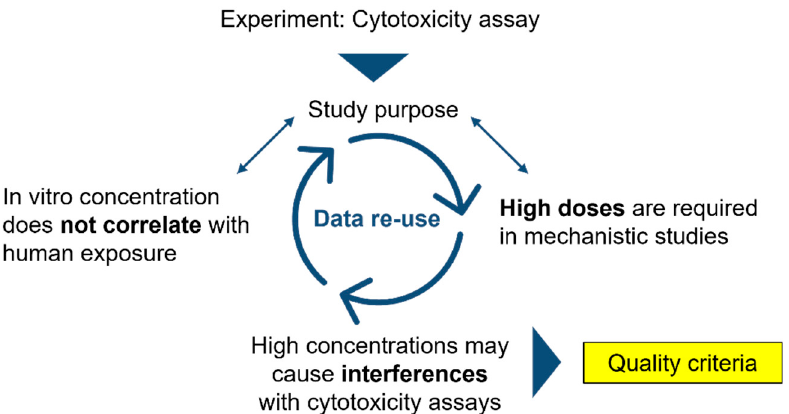
Figure 1. Role of descriptive information and quality criteria. Bold tags are used for